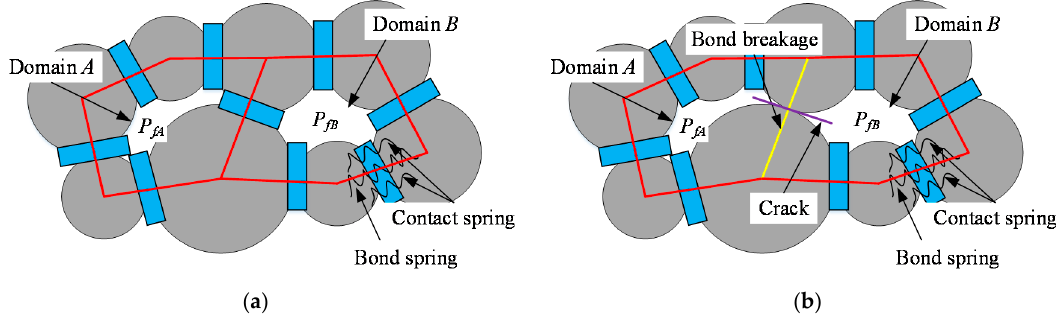
Figure 4. Bond breakage and fluid pressure balancing according to Equation (4) in the two domains. ( a ) Fluid pressure before a crack initiation; ( b ) Fluid pressure after a crack initiation.